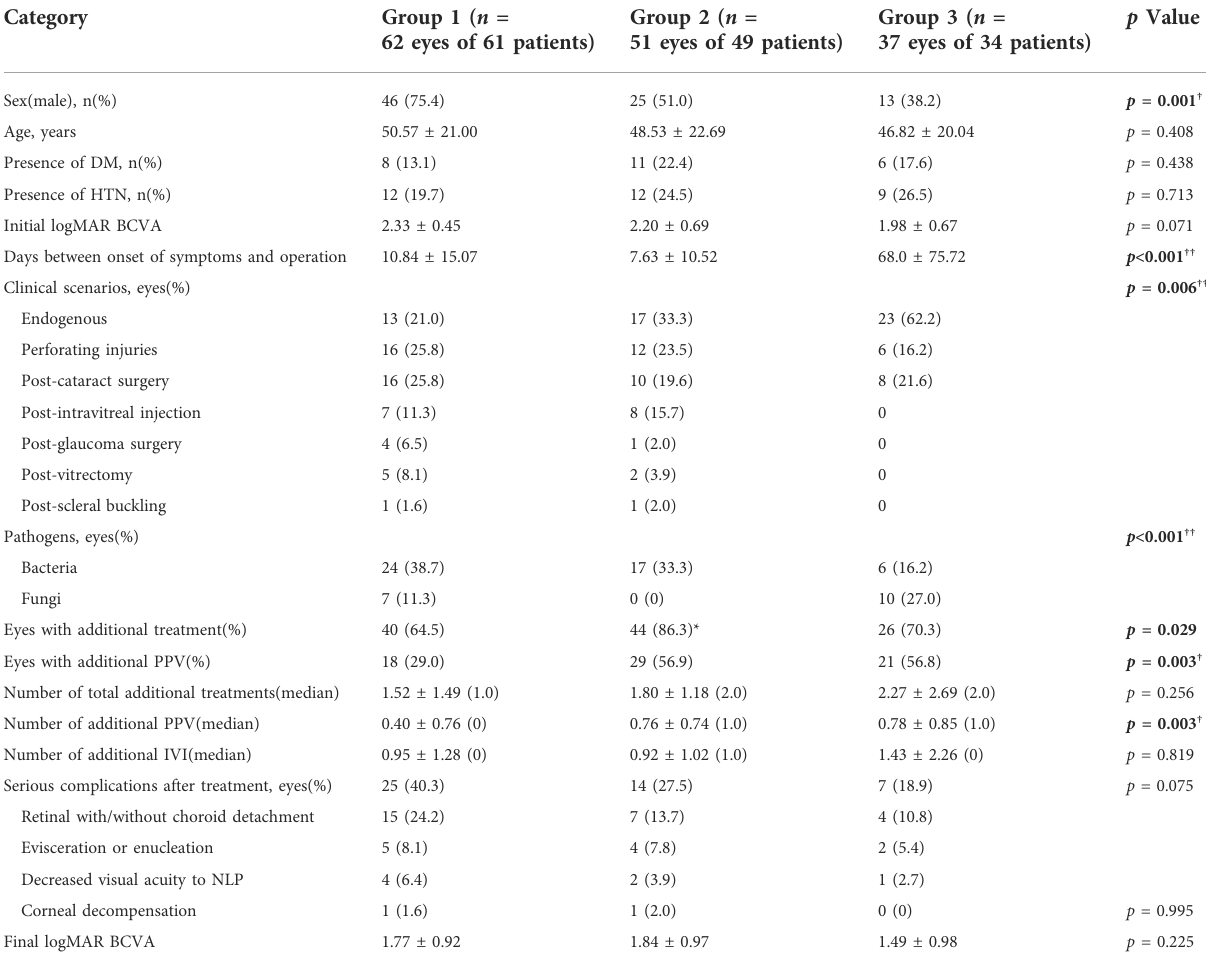
TABLE 4 Clinical characteristics of eyes with three different initial